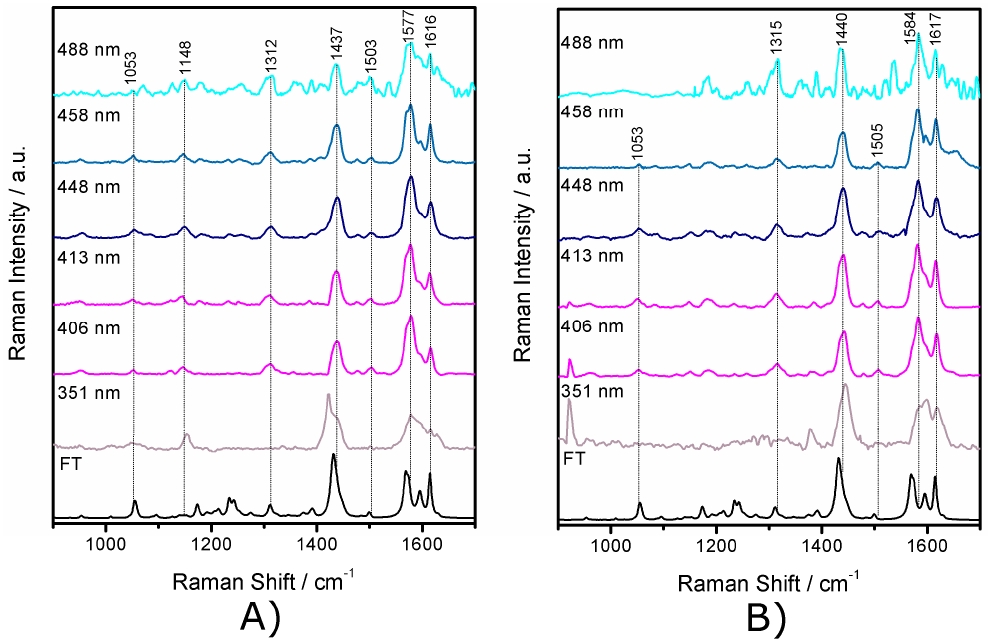
Figure 7. Experimental resonance Raman spectra for 1A (1 mM) recorded in ( A ) toluene and ( B ) MeCN at the wavelengths listed.